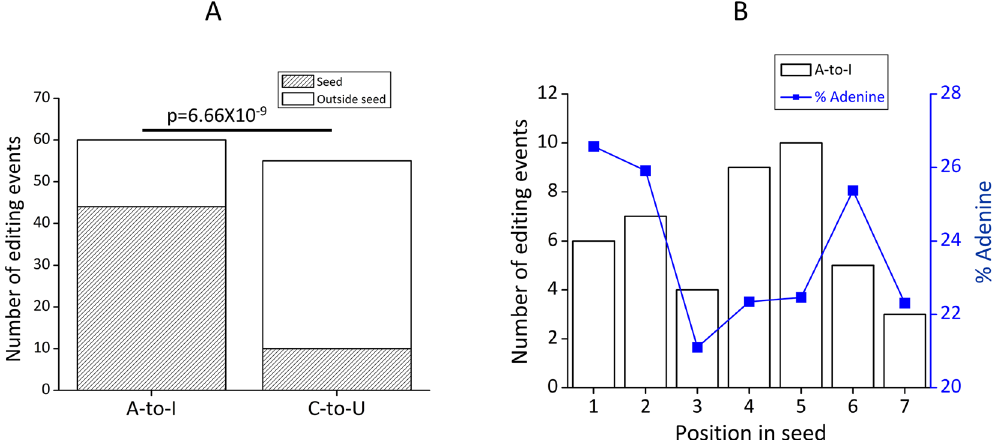
Figure 2. A-to-I editing in mature miRNAs is enriched in seed sequence. ( A ) 73.33% (44/60) of the A-to-I editing events was found to be localized in the seed sequence of mature miRNAs whereas for C-to-U only 17.86% (10/56) were in the seed sequence. This enrichment is significantly (two-tailed proportional test, p = 6.66 × 10 − 9 ) higher for A-to-I compared to C-to-U. ( B ) Primary y-axis (bars) shows the number of editing events in the seed, the secondary y-axis (line) shows the percentage of adenine in seed sequences of all human mature miRNAs (miRBase20) and the x-axis shows the position within the seed (where position 1–7 corresponds to position 2–8 from the 5 ′ -end of mature miRNAs). 19 out of 44 seed editing was located in the 4 th (nine events) and 5 th (ten events) positions of the seed (marked by black arrow) without a bias for adenine at that position in human mature